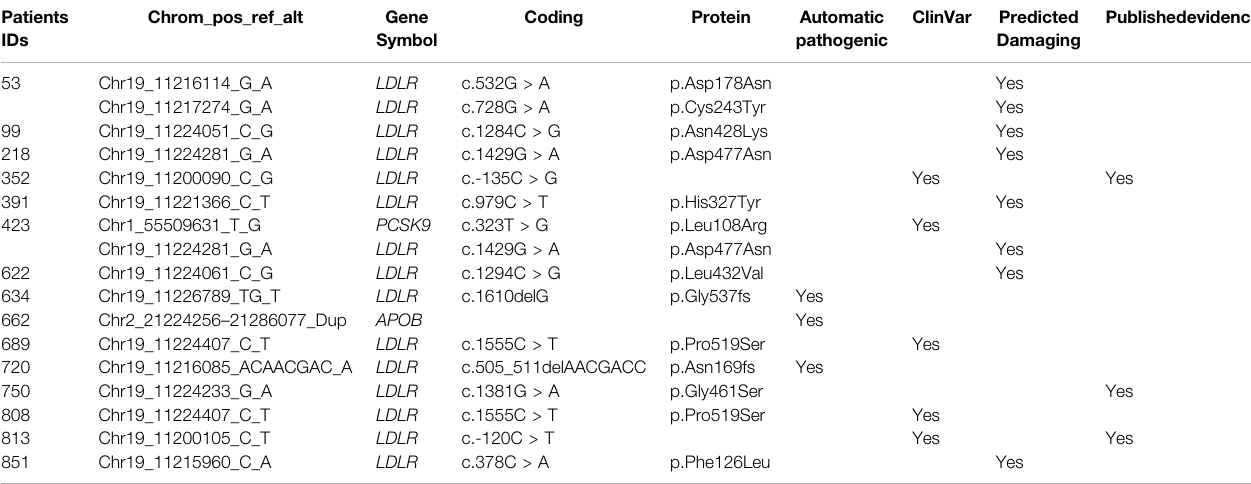
TABLE 2 | FH mutations identi fi ed in 229 participants with clinical FH. Patients